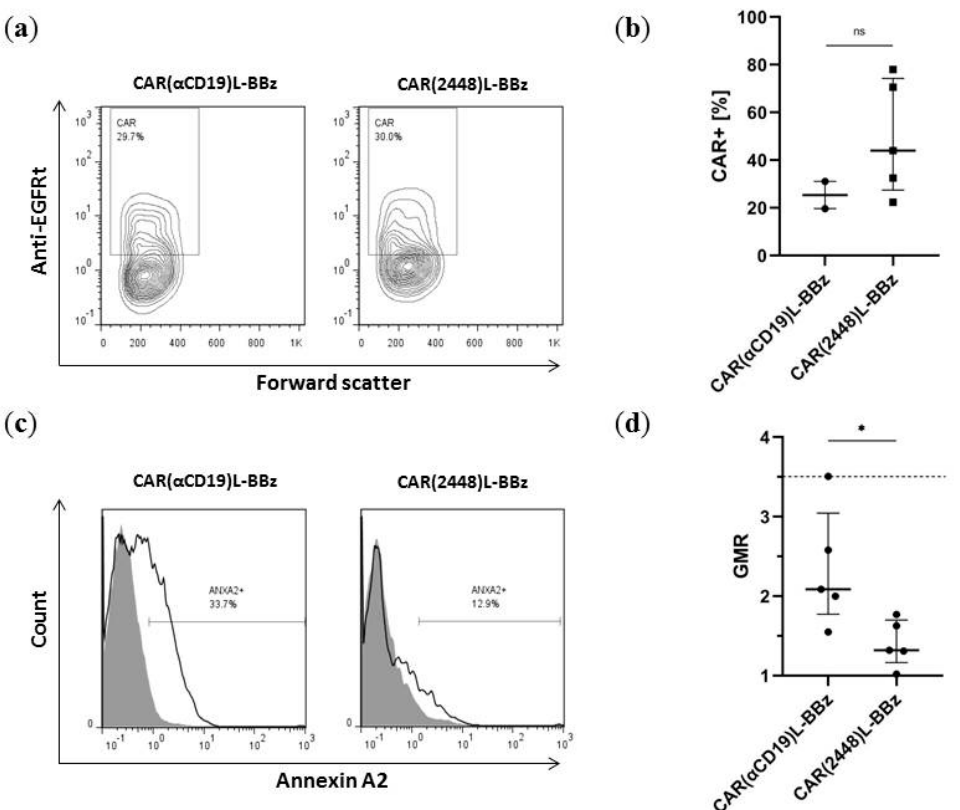
Figure 6. Control of ANXA2 in vivo ( a ) Representative flow cytometry of lymphocytes sampled from mice in endpoint assays. CAR T cell populations are still observed up to experimental endpoints. ( b ) Distribution of CAR T cell persistence in lymphocyte populations of NIKO mice engrafted with CAR T cells. No significant difference in CAR T cell persistence between CAR( α CD19)L-BBz and CAR(2448)L-BBz T cell infused mice. ( c ) Representative flow cytometry of endpoint tumours. Detection of ANXA2 via mAb 2448. ( d ) Distribution of ANXA2 expression in the tumours post CAR T cell treatment. Tumours of mice treated with CAR(2448)L-BBz T cells expressed significantly lower levels of ANXA2 than mice treated with control CAR( α CD19)L-BBz T cells. Dotted line represents geometric mean ratio of SKOV3 cells before injection into mice. For all subfigures, abbreviations: ns not significant. * p < 0.05. GMR—geometric mean ratio between 2448 binding and control.